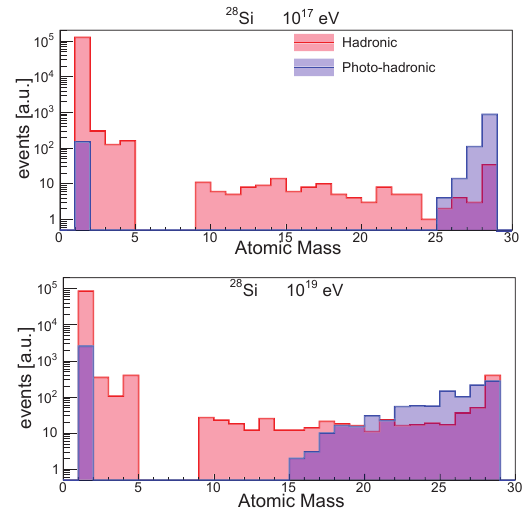
Figure 3. Mass distributions of nuclei escaping from a proto- type starburst galaxy, for primary silicon nuclei with energies 10 17 (top) and 10 19 eV (bottom panel). The blue (red) histogram refers to the propagation in the source when only photo-hadronic (hadronic) interactions are permitted. From [14].